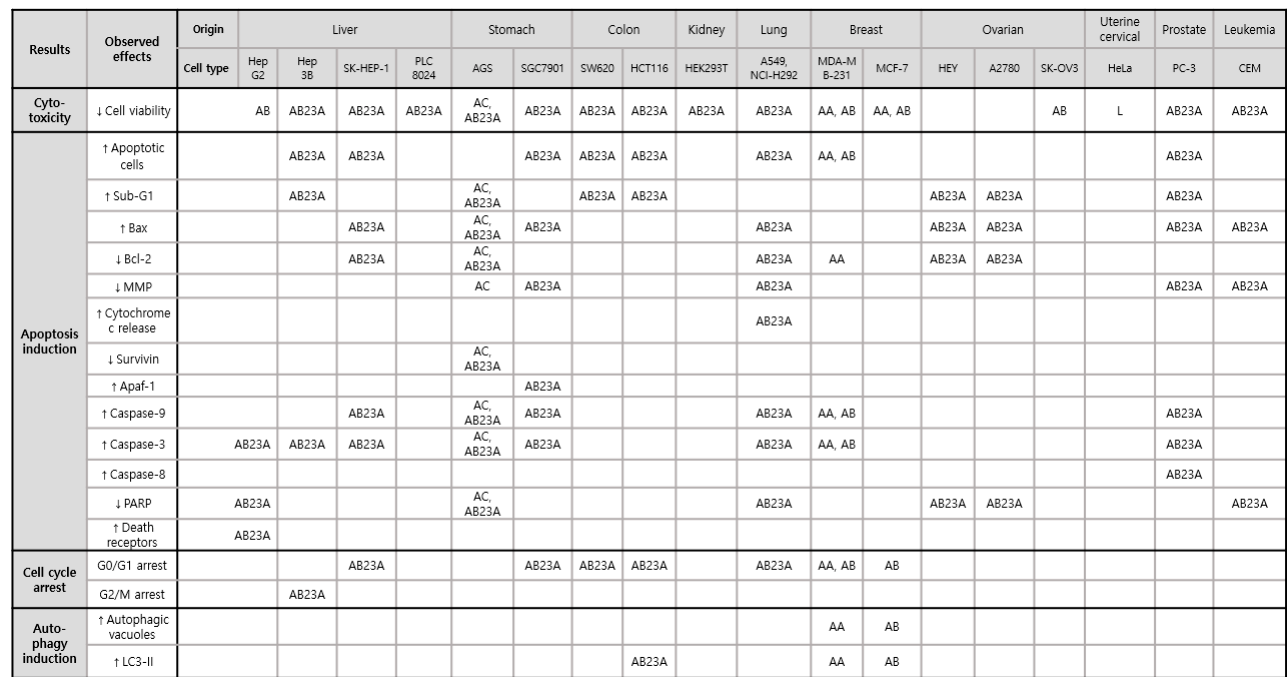
AA, alisol A; AB, alisol B; AB23A, alisol B 23-acetate; Bax, Bcl2-associated X protein; Bcl, B-cell lymphoma; PARP, poly (ADP-ribose) polymerase; CDK, cyclin-dependent kinase; Akt, protein kinase B; ERK, extracellular signal-regulated kinase; ROS, reactive oxygen species; JNK, c-Jun N-terminal kinase. Upward pointing arrows ( ↑ ) and downward pointing arrows ( ↓ ) indicate an increase or a decrease in a numerical value, rate, change, or degree, respectively.